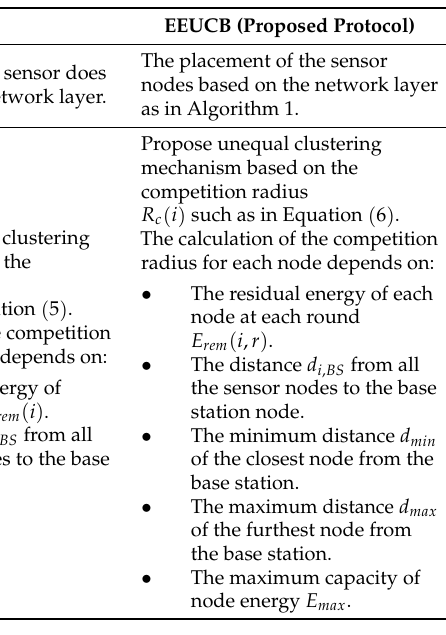
Table 10. Comparison between our method and prior